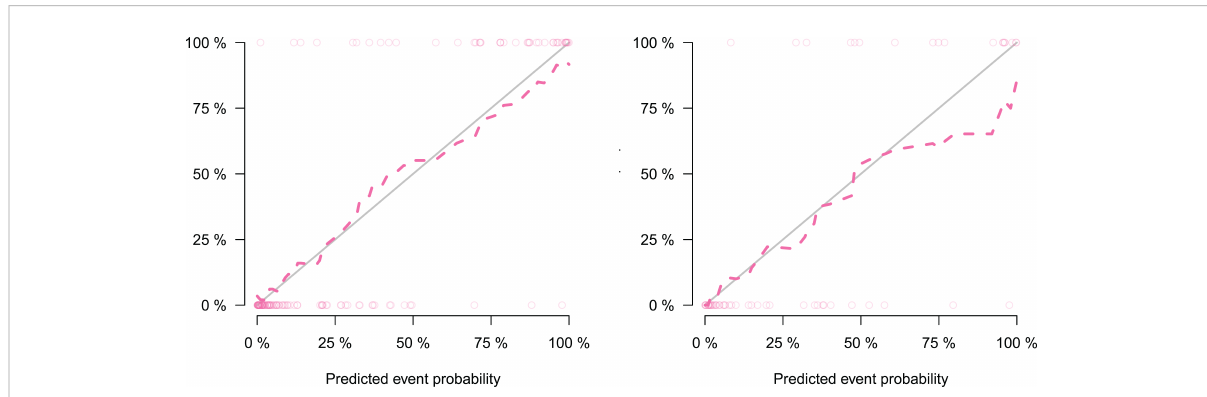
FIGURE 7 Calibration curve of radiomics nomogram, which showing the relationship between the predicted value and the true value. Left: calibration curve of the training cohort; Right: calibration curve of the validation cohort. The closer the dotted line is to the solid line, the better the predictive power of the